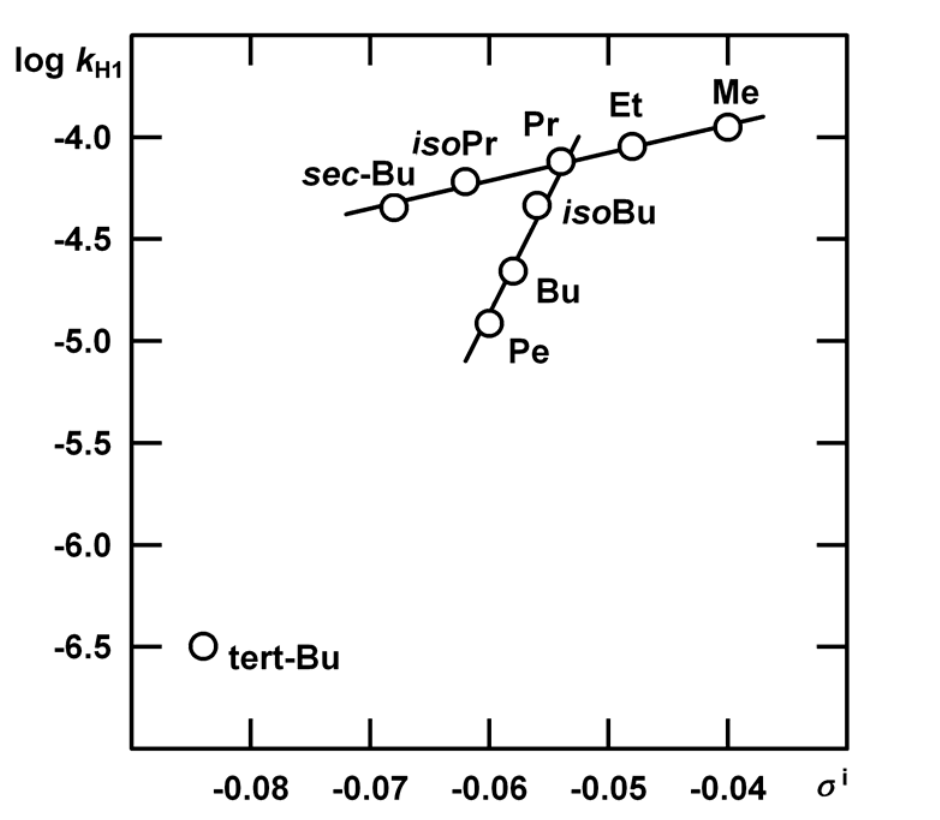
of acid-catalysed hydration of Figure 2. Dependence of rate constants k H1 α -alkylstyrenes upon substituent constants σ i ; the points are interlaced by regression straight